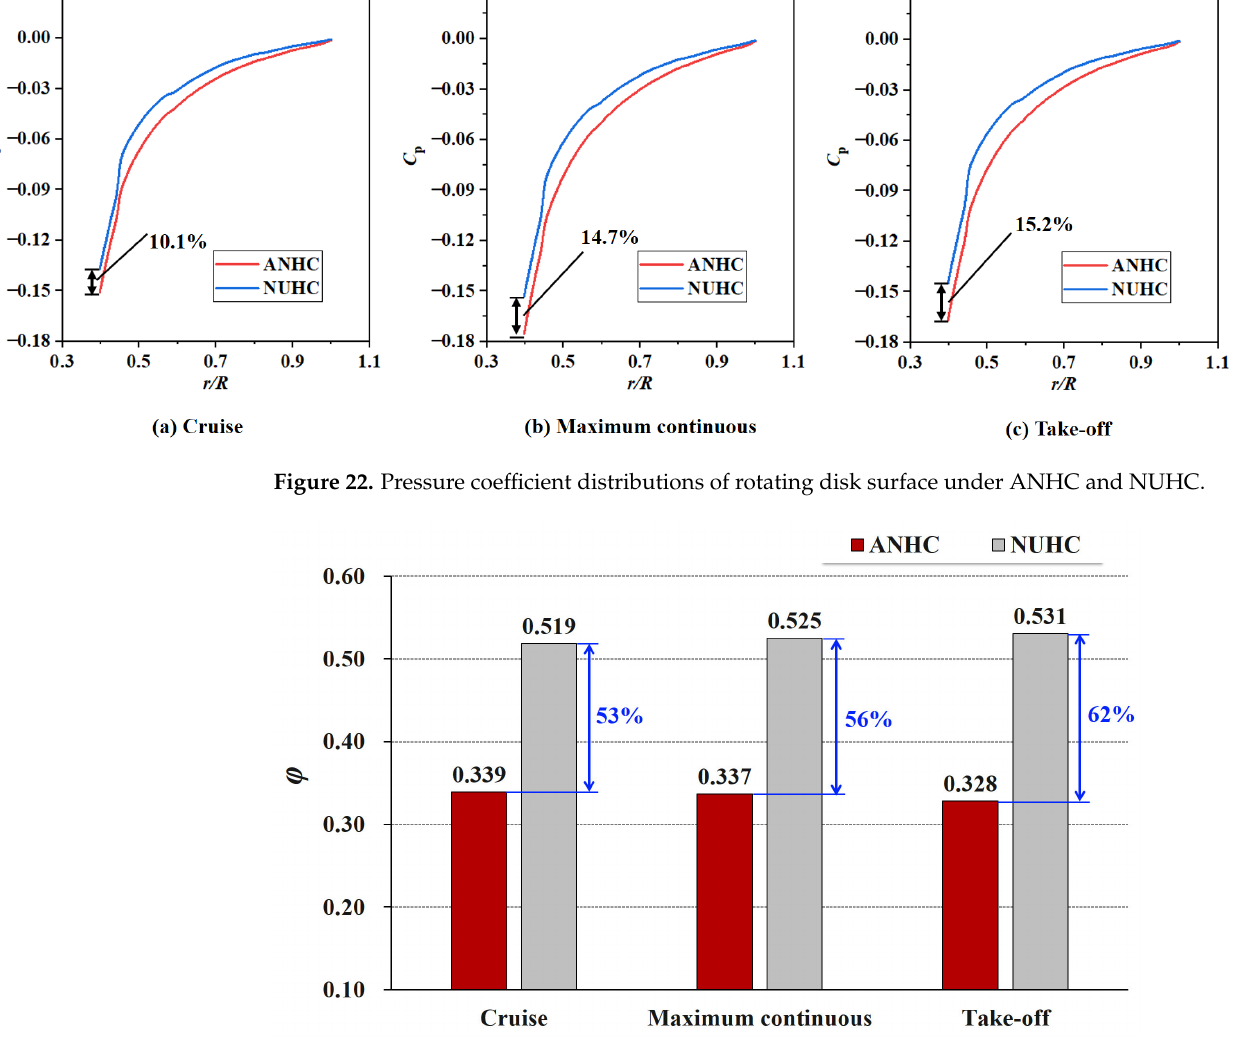
Figure 23. Flow coefficients of the rotor ‐ stator cavity under ANHC and NUHC.